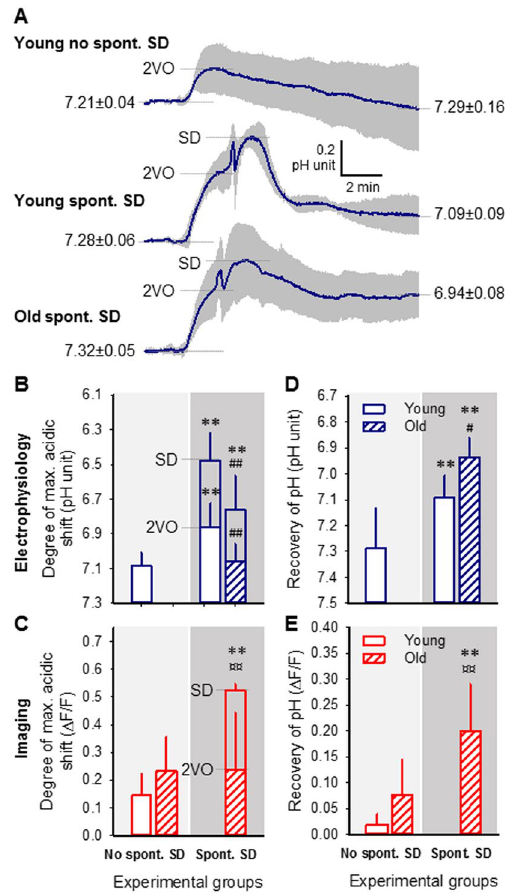
Figure 6. Tissue pH variations induced by ischemia and spontaneous spreading depolarization (SD). ( A ) Mean traces of tissue pH variation due to ischemia induction (2VO) and spontaneous SD are superimposed. Each trace is the average of individual ones taken from separate animals, and are presented as mean ± stdev (n = 6/8). In Panels B, C, D and E, the upper bar charts represent data obtained with pH-sensitive microelectrodes (blue), and the lower bar charts demonstrate data derived from Neutral Red (NR) fluorescence imaging (red). Light shaded background of the bar charts (left) labels experiments devoid of spontaneous SD, and dark shaded background in the bar charts (right) stands for experiments in which spontaneous SD occurred. ( B , C ) Amplitude of acidosis. ( D , E ) Tissue pH assessed 12 min after SD occurrence (i.e. tissue pH recovery). For the evaluation of statistical significance, a two-way analysis of variance (ANOVA) paradigm considering age and the occurrence of spontaneous SD as its factors was applied. Level of significance for the ANOVA was defined as * p < 0.05 and ** p < 0.01. Significant differences between groups were determined by a Fisher post hoc test as follows: * p < 0.05 and ** p < 0.01, vs. respective Young; # p < 0.05 and ## p < 0.01, vs. respective with no spontaneous